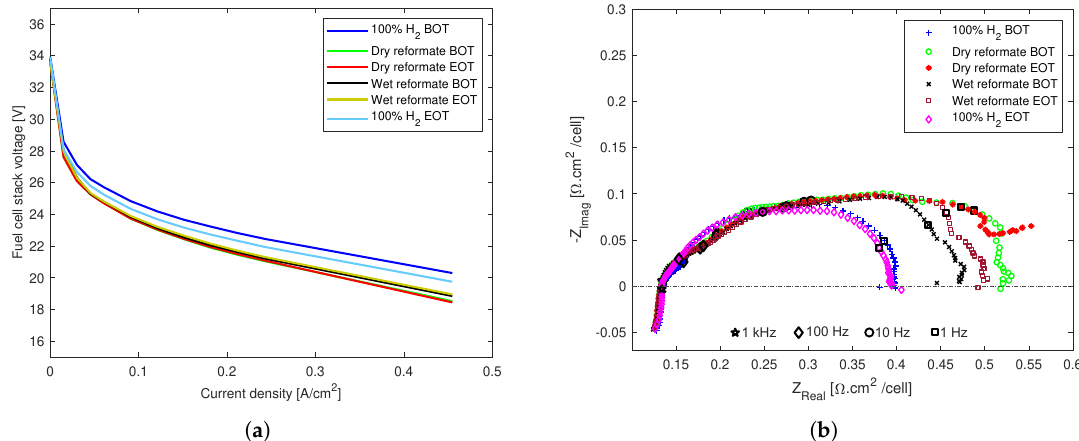
Figure 8. The effects of dry and wet reformate impurities on an HT-PEMFC stack with an MEA composed of a pre-doped PBI membrane and woven GDL. ( a ) Polarization curves. ( b ) EIS